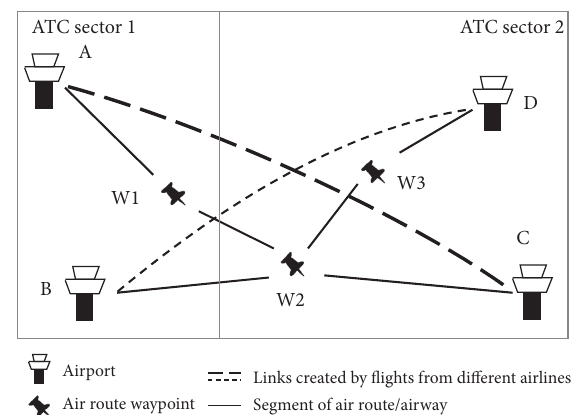
Figure 1: Illustration of air transportation